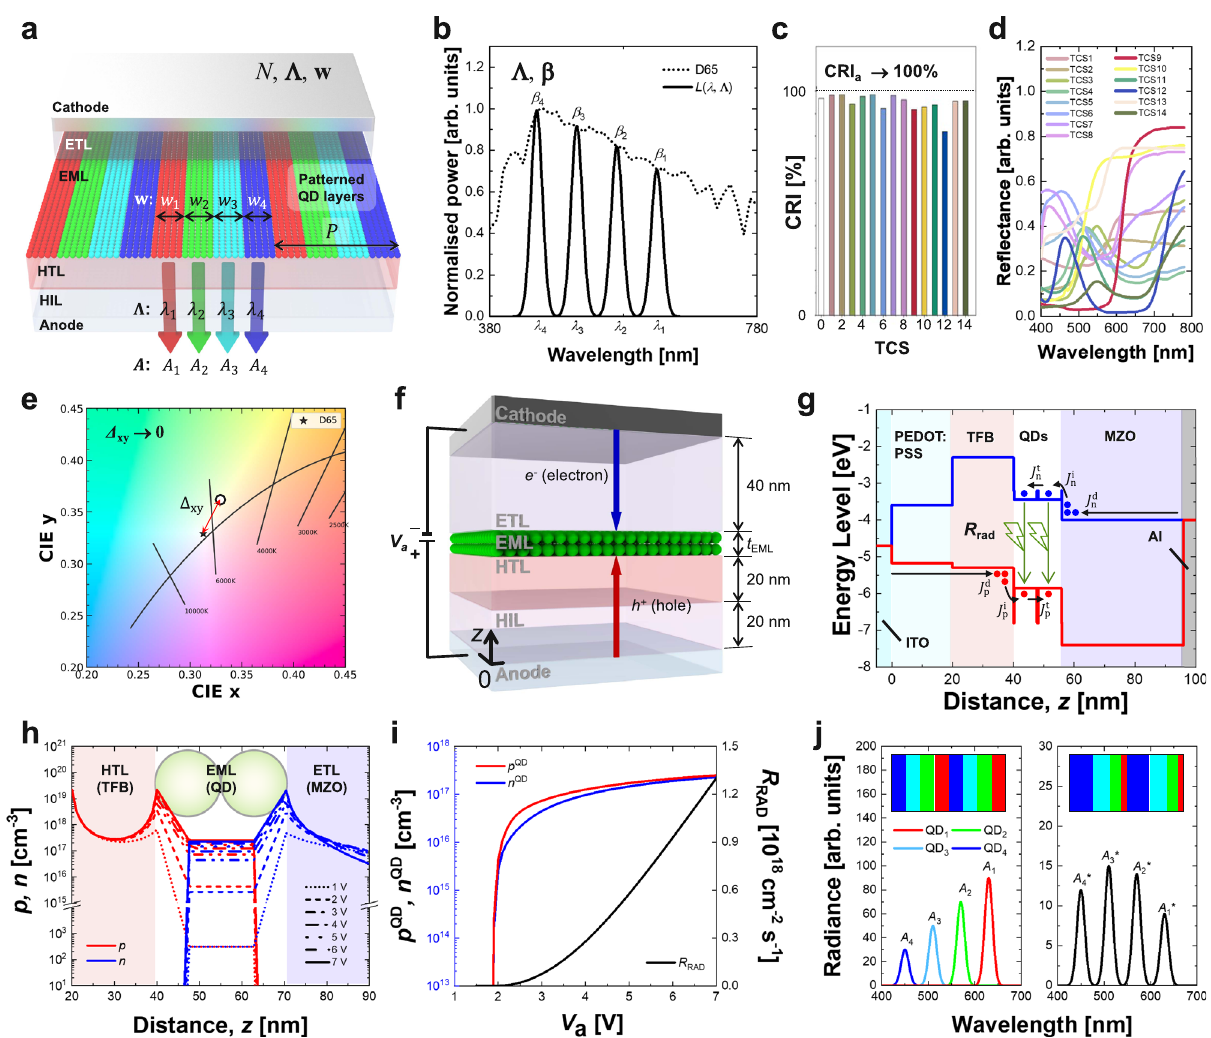
Fig. 1 A system architecture and design procedure of multi-primary coloured lighting system with patterned QD-LEDs. a N -primary coloured lighting system. N is the number of primary colours; Λ = ( λ 1 , λ 2 , … , λ N ) is a set of peak wavelengths ( λ i ), w = ( w 1 , w 2 , … , w N ) is a set of emission widths ( w i ), and A = ( A 1 , A … , A A i- th QD pattern. P is the pitch of the pixel group. ETL electron transport layer, EML emissive layer, HTL hole transport i ) for 2 , N ) is a set of peak radiances ( layer, HIL hole injection layer. b An emission spectrum of white lighting system to be optimised by the colour optimisation process. D65 is a normalised power distribution of the CIE D65 standard illuminant, and L is a power distribution of any given white lighting system. β = ( β 1 , β 2 , … , β N ) is a set of peak powers ( β i ) normalised for the D65 power distribution. c Exampled CRI values of a given emission spectrum over the test colour samples (TCSs). CRI a is the average CRI of TCSs from 1 to 8. d Re fl ectance spectra of 14 TCSs. e Chromaticity difference Δ xy from the CIE D65 illuminant. f A strati fi ed layer structure of a monochromatic QD-LED device used in the charge transport simulation. z spatial variable, t EML thickness of EML. g A fl at-band energy-level diagram across the device with respect to the distance from the anode electrode. ITO indium tin oxide, TFB Poly[(9,9-dioctyl fl uorenyl-2,7-diyl)-co-(4,4 ’ -(N-(4-sec-butylphenyl)diphenylamine)], QDs quantum dots, MZO magnesium-doped zinc oxide, Al aluminium. PEDOT:PSS is a poly(3,4-ethylenedioxythiophene)-poly(styrenesulfonate). J p d , J n d , J p i , J n i , J t , and J t are drift-diffusion, injection, and tunnelling current densities for holes (subscript p) and electrons (subscript n). R p n RAD is a radiative recombination rate per unit area. h Hole and electron density distributions for the applied voltages. i Simulated voltage dependencies of hole density ( p QD ), electron density ( n QD ), and R RAD at QD layer. j Schematic illustration of the emission peak adjustment by changing pattern widths. A i * is adjusted peak radiance of i -th QD pattern. Insets are the emission pattern layouts of the devices with identical emission widths and different emission